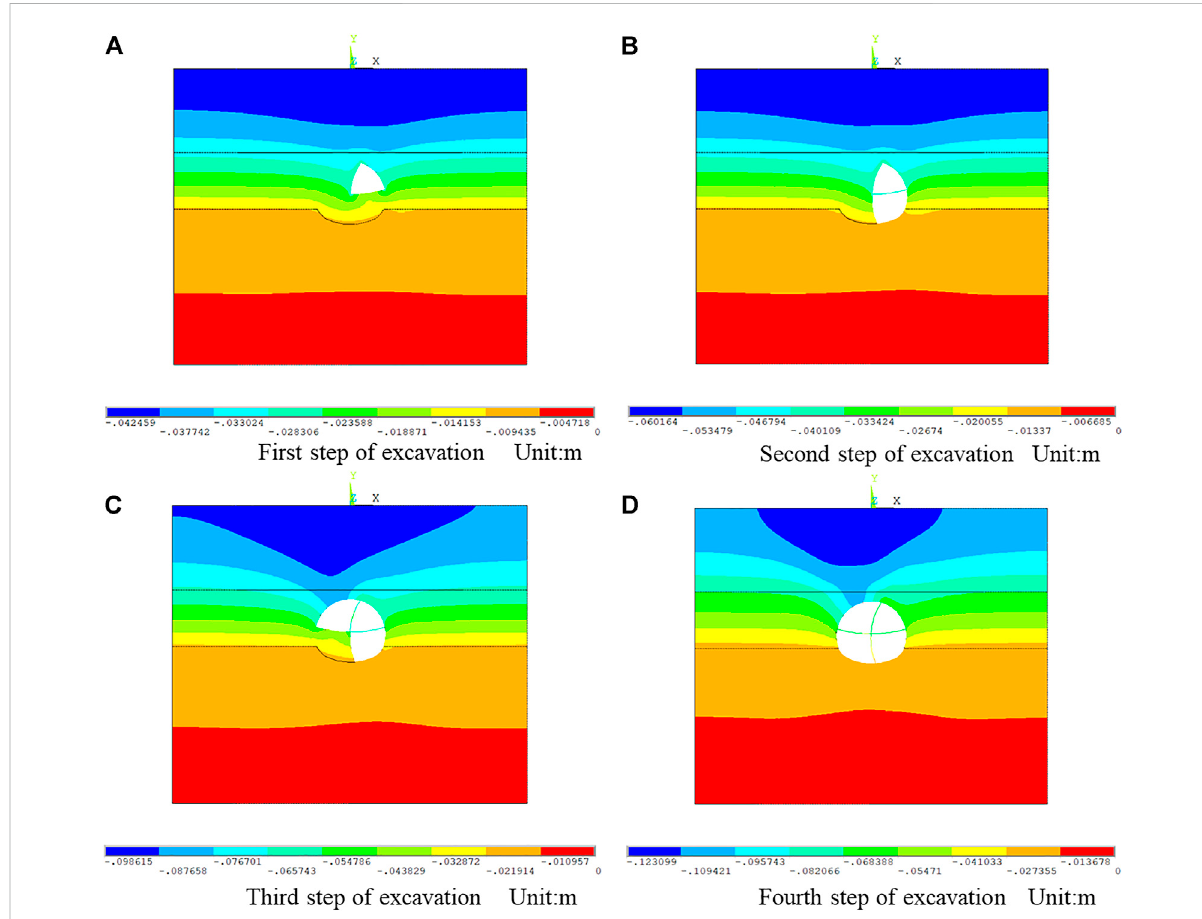
FIGURE 6 Y-directiondisplacementcloud. (A) Firststep ofexcavation,unit: m. (B) Secondstepofexcavation,unit:m. (C) Thirdstepofexcavation,unit:m. (D) Fourth step of excavation, unit: